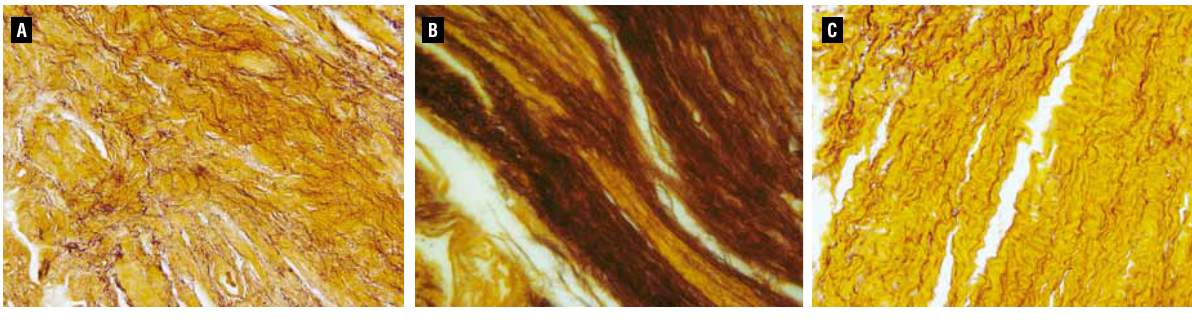
Figure 2 - Elastic system fibers distribution in urethral samples from Controls (A), Proximal edge of stenotic group (B) and distal edge of stenotic group (C). Note marked increase of elastic fibers in the proximal edge and similar content in the distal edge, when compared to controls. Weigert’s Resorcin-Fuchsin, X400.